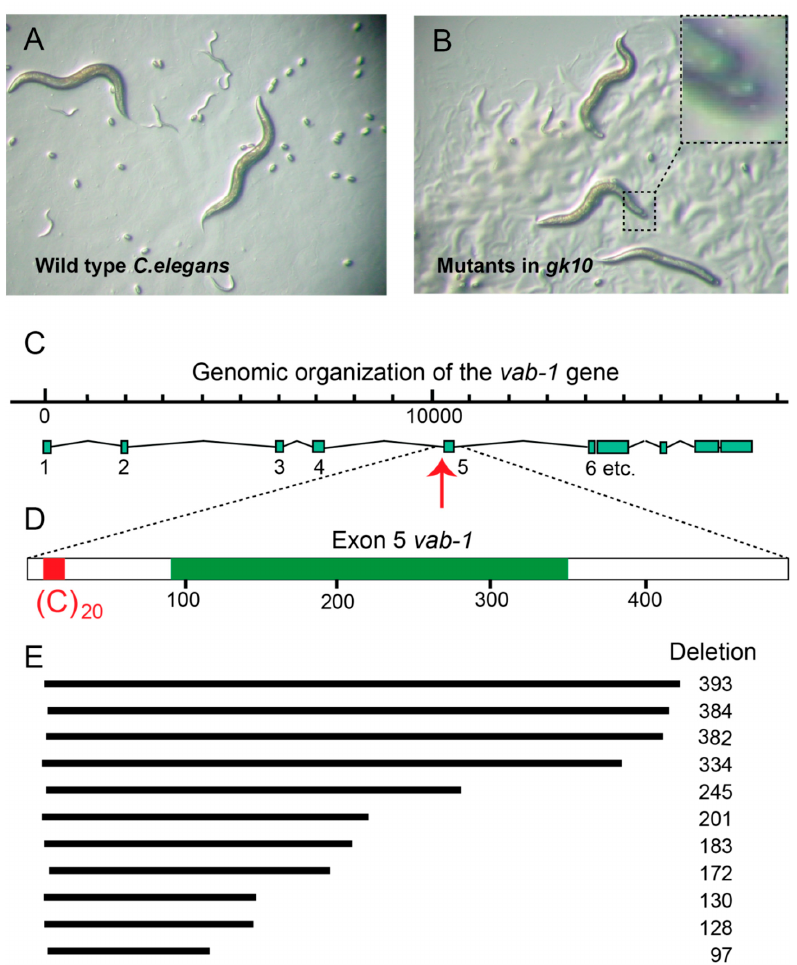
Figure 3. Deletions in helicase deficient C.elegans strain gk10 show characteristic deletions throughout their genome that invariable start at the 3 ′ end of G ‐ rich DNA. (A) Wild type animals. (B) Offspring their genome that invariable start at the 3 (cid:48) end of G-rich DNA. ( A ) Wild type animals. ( B ) O ff spring of of gk10 with a “ variable abnormal ( vab )” notched head phenotype (insert). (C, D, E) Genetic gk10 with a “ variable abnormal ( vab )” notched head phenotype (insert). ( C – E ) Genetic complementation complementation assays pointed to mutations in the vab ‐ 1 gene and PCR studies revealed that the vab phenotype in gk10 animals result from deletions close to exon 5 of the vab ‐ 1 gene. Deletions that assays pointed to mutations in the vab-1 gene and PCR studies revealed that the vab phenotype in gk10 invariably start at the 3 ′ end of G ‐ rich DNA were identified throughout the C.elegans genome in ~50% animals result from deletions close to exon 5 of the vab-1 gene. Deletions that invariably start at the 3 (cid:48) of poly guanine tracts longer than 18 G’s. Numbers represent base pairs. end of G-rich DNA were identified throughout the C.elegans genome in ~50% of poly guanine tracts longer than 18 G’s. Numbers represent base